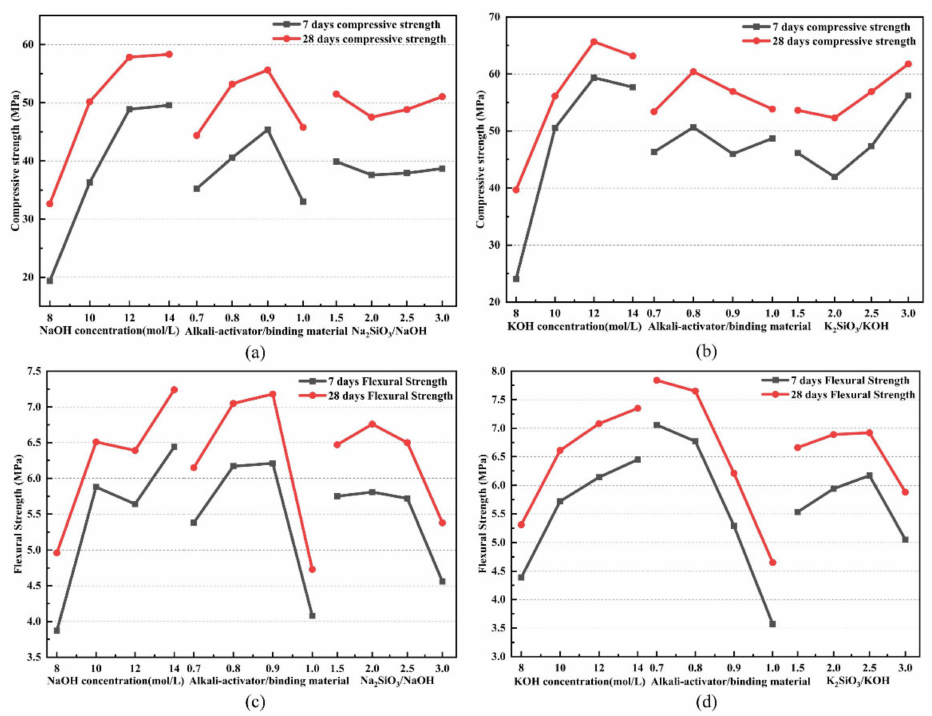
Figure 3. Factorial diagrams of the main parameters: ( a ) factorial diagrams of the main parameters that affected the compressive strength of the Na-based geopolymer samples, ( b ) factorial diagrams of the main parameters that affected the compressive strength of the K-based geopolymer samples, ( c ) factorial diagrams of the main parameters that affected the flexural strength of the Na-based geopolymer samples, and ( d ) factorial diagrams of the main parameters that affected the flexural strength of the K-based geopolymer